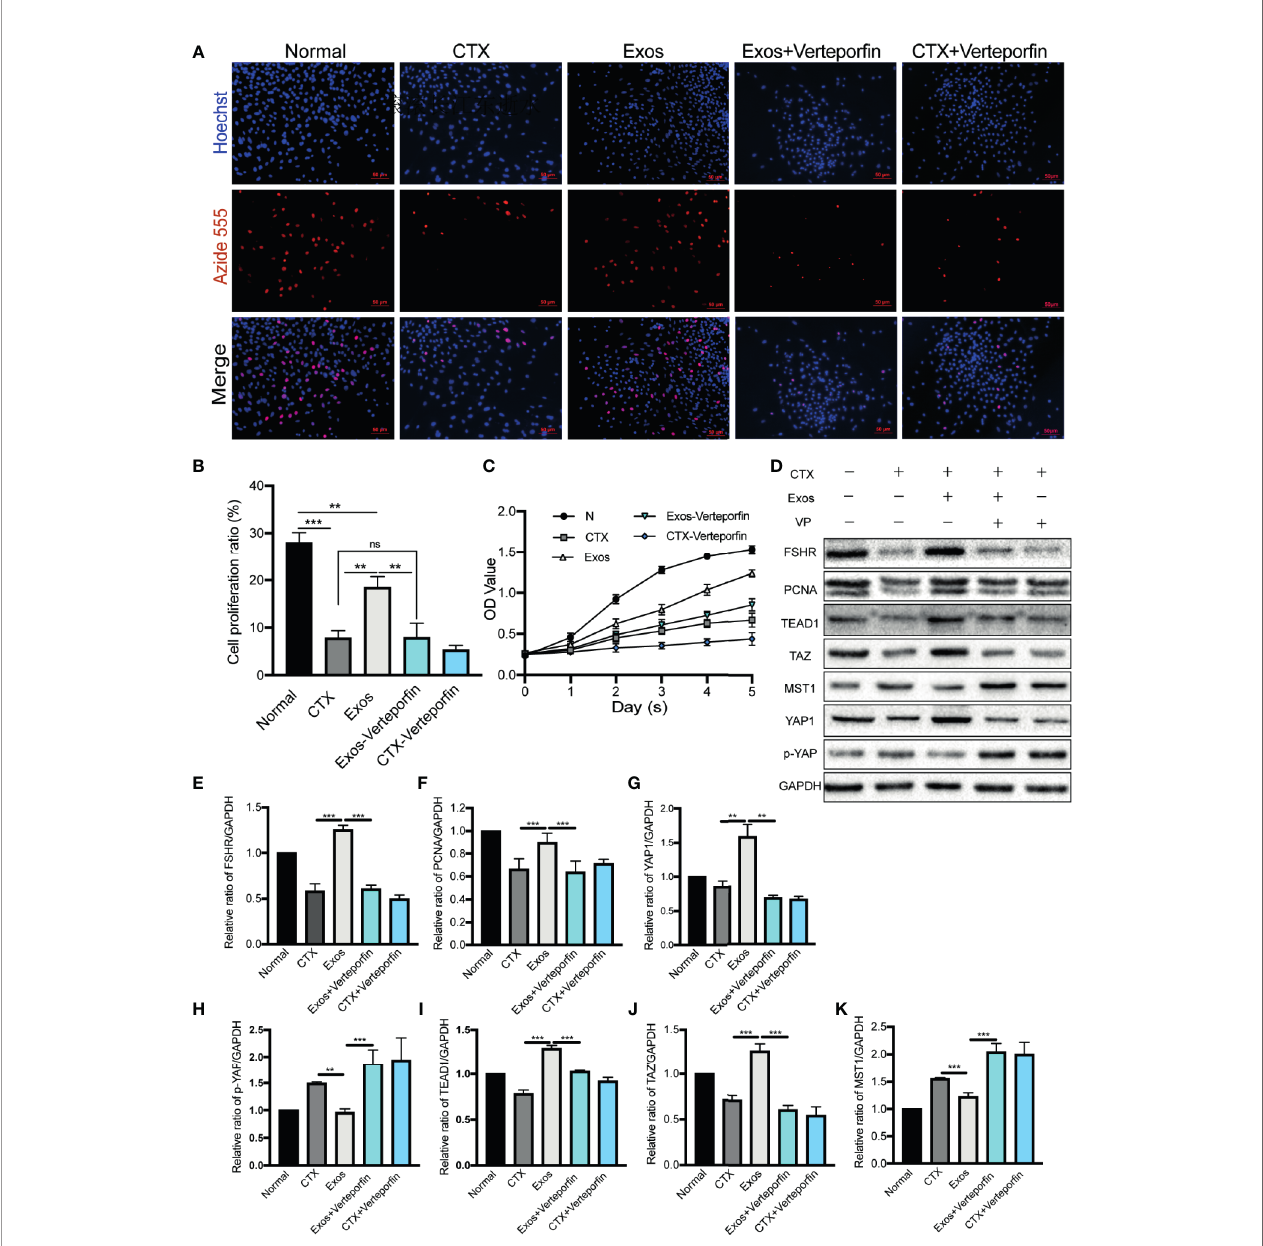
FIGURE 7 | Exosomes promoted GCs proliferation by regulating the Hippo pathway in vitro . (A) The EdU assay showed that hUCMSC-Exos promoted GCs proliferation, while the inhibitor of YAP, vertepor fi n, reversed this effect. Scale bar: 50 m m. (B) Proliferative ratio of GCs in fi ve different groups was analyzed through the EdU assay. (C) Cell proliferation curve of GCs from day 0 to day 5 in the fi ve groups, as measured by the CCK-8 assay. (D) Representative immunoblots of biomarkers of proliferation and the Hippo pathway in the fi ve groups, using GAPDH as reference. Quanti fi cation of protein expression levels of (E) FSHR, (F) PCNA, (G) YAP1, (I) TEAD1, (J) TAZ, (H) p-YAP, and (K) MST1 revealed that exosomes promoted GCs proliferation by regulating the Hippo pathway, and the therapeutic effects were suppressed by vertepor fi n. Data are presented as the mean ± SD. * p < 0.05, ** p < 0.01, *** p < 0.001, ns, no signi fi cance. Data are representative of three independent experiments in each